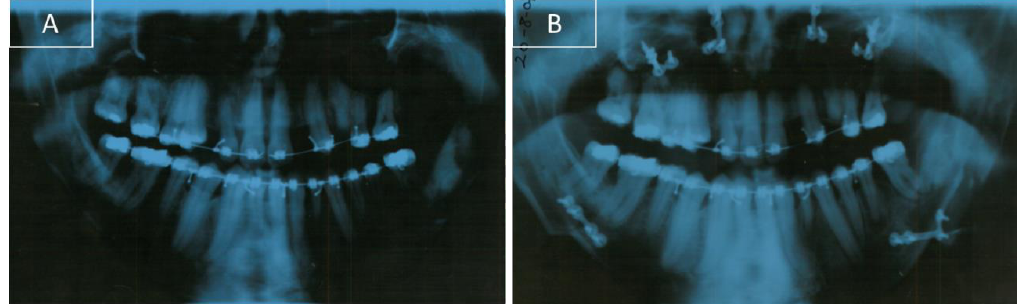
Figure 6. Orthopantomography during orthodontic treatment. ( A ) Before surgery with the fixed appliances. ( B ) After surgery.